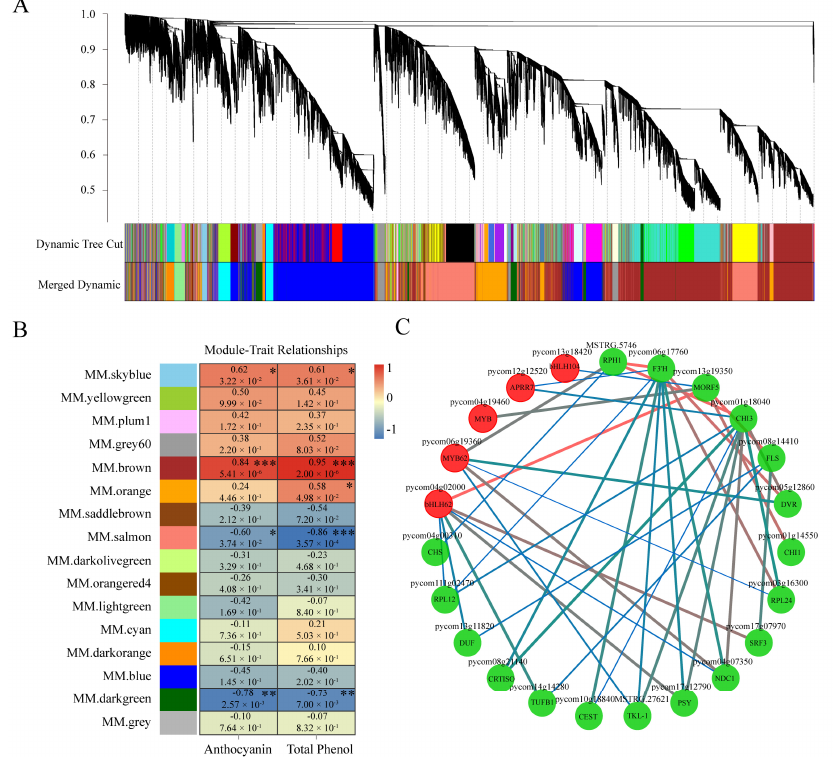
Figure 9. WGCNA of differentially expressed genes under sucrose treatment. ( A ) Hierarchical cluster analysis of the non-redundant DEGs involved in 16 modules. The co-expressed DEGs were exhibited at the end of the branches in the hierarchical cluster tree, and the modules were represented by designated colors. ( B ) Correlation analysis of the modules and the total anthocyanin and phenol content. The panel with designated colors indicates different modules. The color scale represents the correlations between different modules and corresponding traits. The upper data in each box indicate the value of correlations and the data below indicate the p -value. Asterisks indicate statistical significance (*, p < 0.05; **, p < 0.01, ***, p < 0.001). ( C ) Cytoscape analysis of the co-expressed DEGs in the module of “MM. skyblue”. The dots with red and green colors indicate the regulatory genes and structural genes, respectively. The red and blue lines indicate higher and lower weight value,